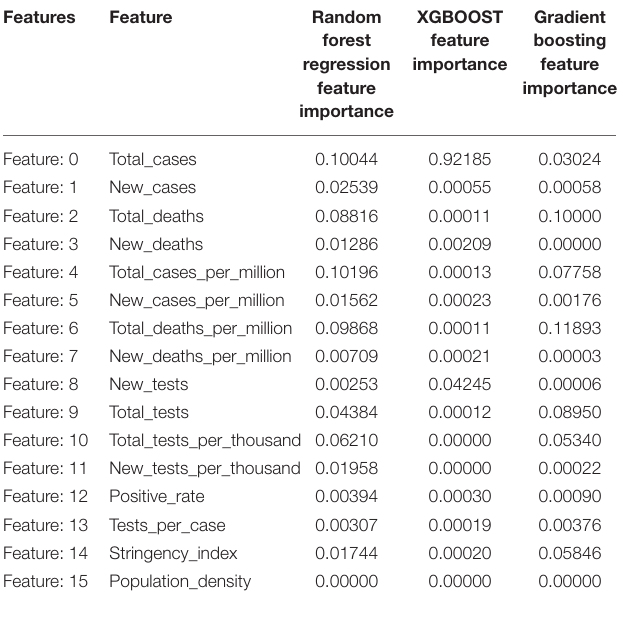
TABLE 1 | Feature Importance Scores obtained using Random Forest Regression, XGBoost, and Gradient Boosting.